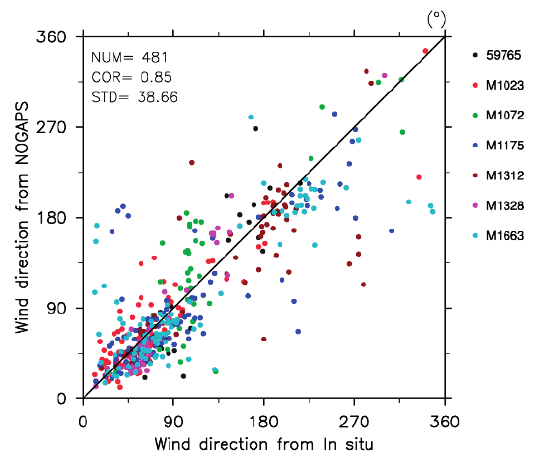
Figure 5. Wind directions from in situ measurements vs. NOGAPS.